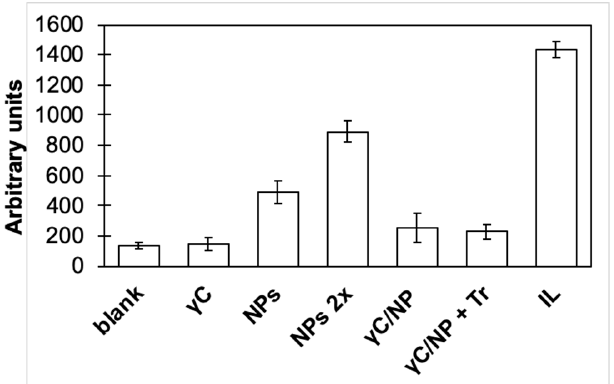
Figure 7. Effects on the Caco-2 transfected cell NFkB pathway of the γ C, NP, and γ C/NPs complex. γ C/NPs+Tr was the complex treated with trypsin for 60 min, as shown in Figure 6. See the text for experimental details. Blank areas are the Caco-2 cells incubates alone (negative control), whereas IL is the cells incubated with IL1 β (positive control).